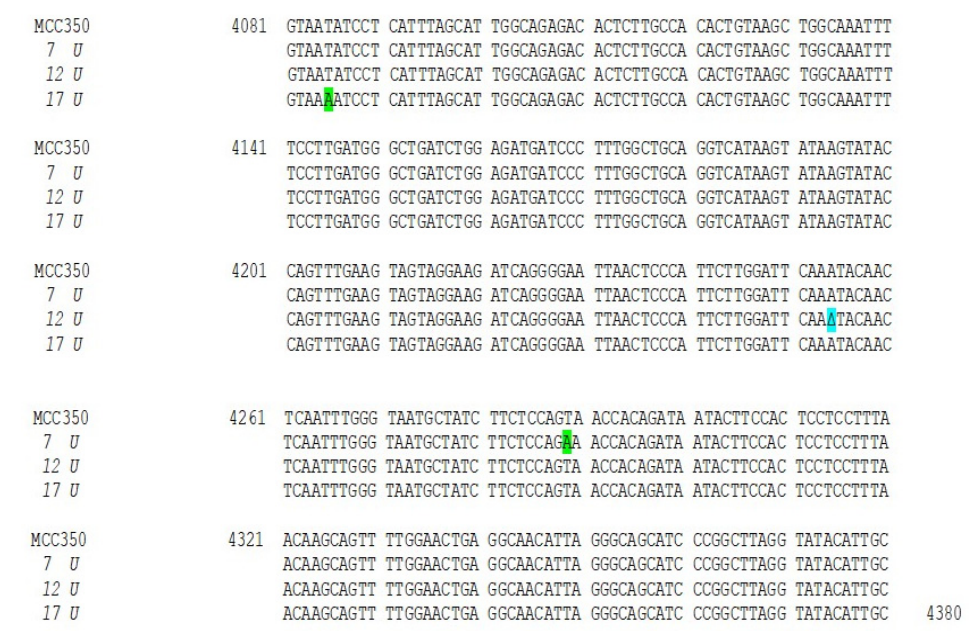
Figure 2. Nucleotide analysis of MCPyV VP1 in urine samples. The alignment is shown between the nucleotide sequence from 4081 to 4380 of the published sequence of MCPyV in GenBank (MCC350) [20] and that obtained from the sequencing of urine positive for MCPyV VP1 (MCPyV 7 U, 12 U, 17 U). Highlighted in green: the 4289 T to A transversion in 7 U and the 4085 T to A transversion in 17 U. Highlighted in blue: the single 4254 ∆ (A) in 12 U.